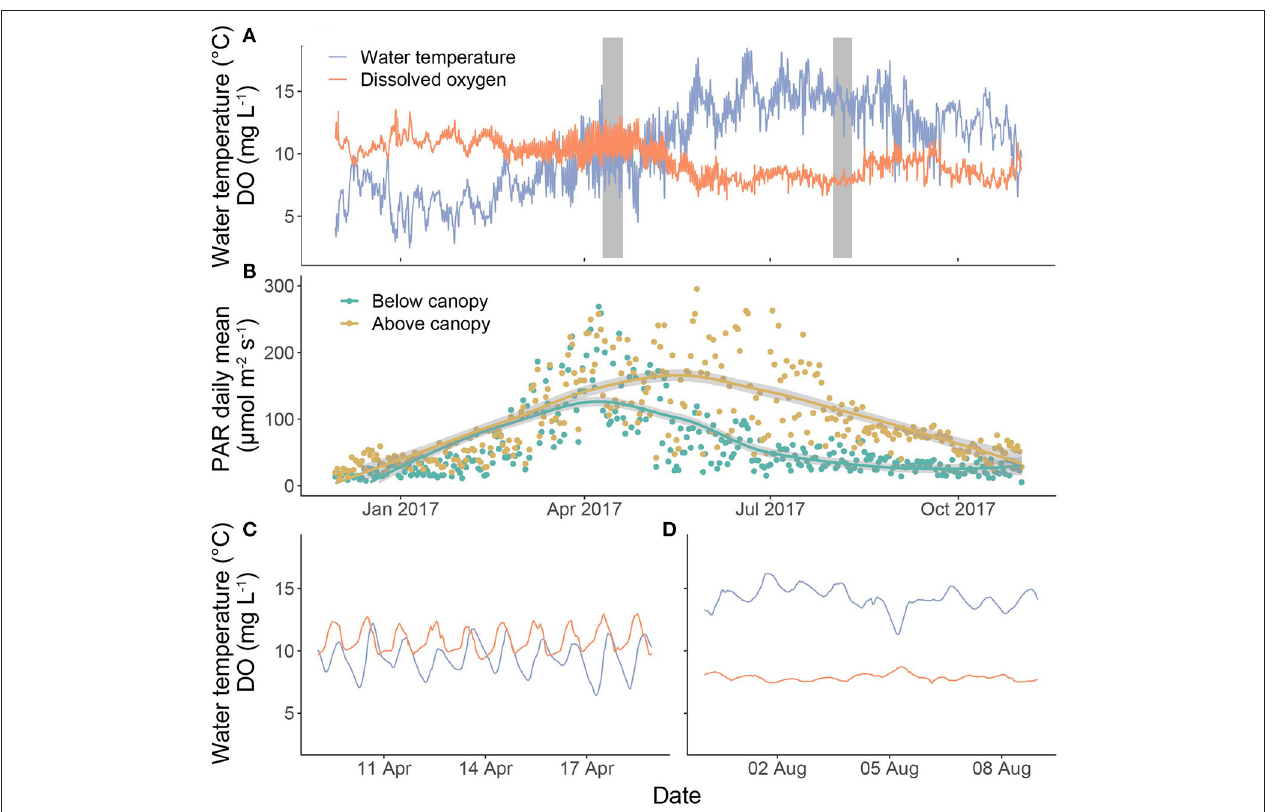
FIGURE 3 | Time series of (A) hourly water temperature and dissolved oxygen (DO) across the study period, (B) daily means of photosynthetically active radiation (PAR) above and below the canopy. Fitted lines are LOESS smoothers (span = 0.8). Grey bars in (A) highlight the periods selected as examples of spring (C) and summer (D) diel patterns in DO and water